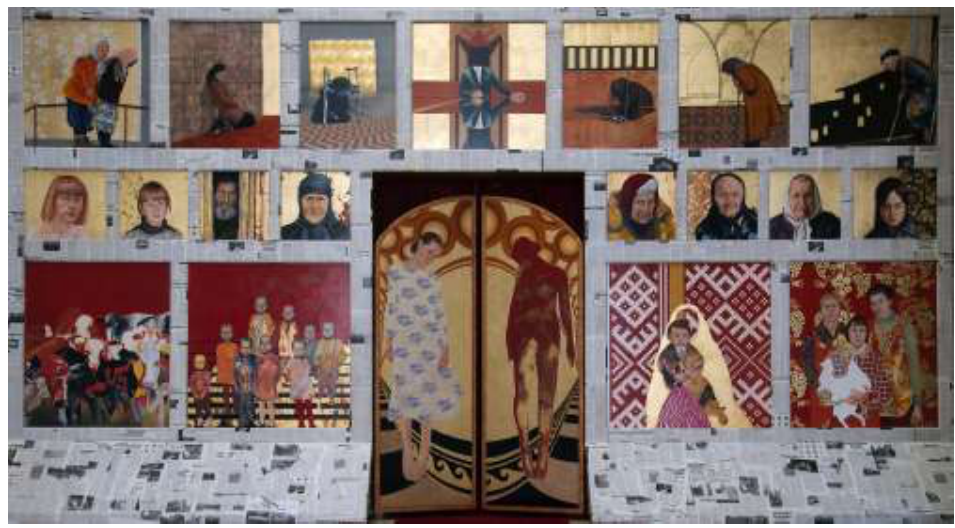
Installation view of Synaxis, South Broadway Cultural Center, Albuquerque, photograph by Julia Lambright,